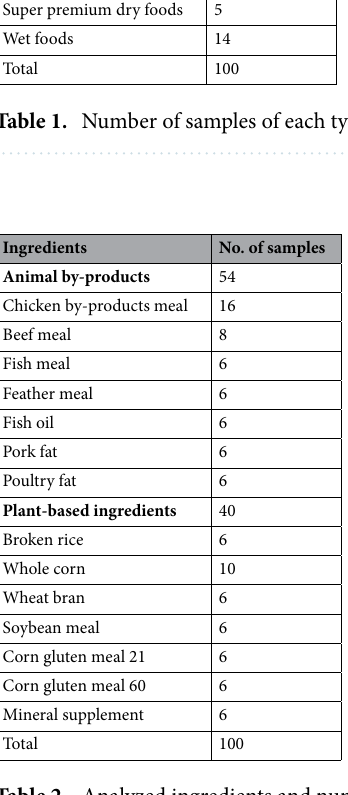
Table 2. Analyzed ingredients and number of samples per ingredient.